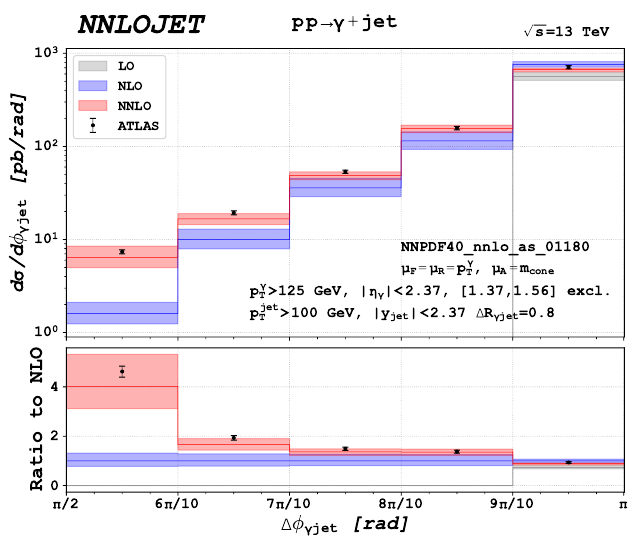
Figure 7. Predictions for the photon-plus-jet cross section as a function of the azimuthal angular separation between the photon and the jet at LO, NLO, and NNLO. The predictions are compared to data from the ATLAS measurement